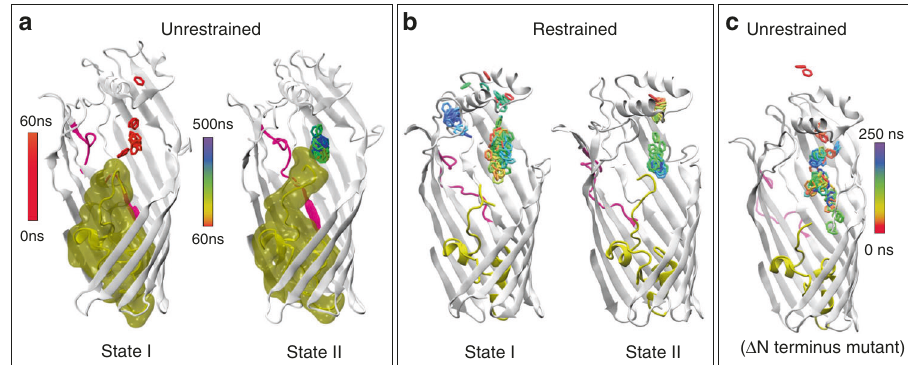
Fig. 2 An N-terminal conformational change generates a high-af fi nity binding site. a Movement of a single benzene within the unrestrained wild-type protein, corresponding to the simulation shown in Supplementary Fig. 2a. The benzene becomes con fi ned to the P-pocket after the protein undergoes a conformational rearrangement to state II, after about 60 ns. The surface of the plug domain (yellow) is shown to emphasise the difference in conformation. b Benzene is mobile with the N-terminus of the protein restrained in state I (left panel), whereas restraining the N-terminus in state II rapidly con fi nes the benzene to the P-pocket. c Benzene freely diffuses through the protein in simulations of the N-terminal deletion mutant. All simulations show benzene molecules from 250 equally spaced frames, according to the colour scheme indicated (0 ns, red; 250 or 500 ns,